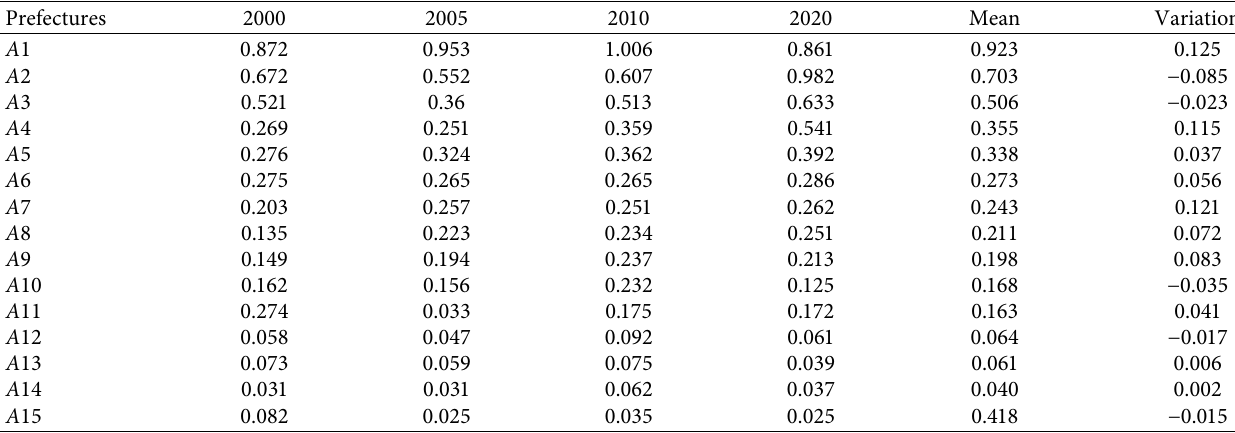
Table 2: Composite scores of regional spatiotemporal development of higher education.